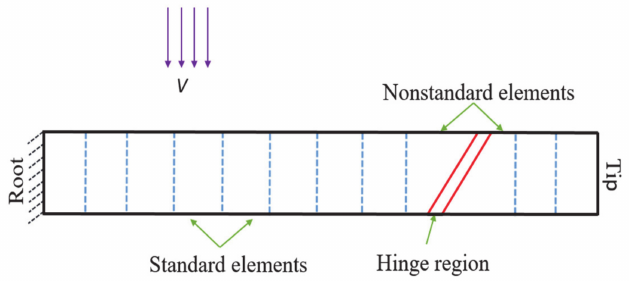
Figure 4. Top-view of a rectangular, cantilever wing equipped with flared hinge folding